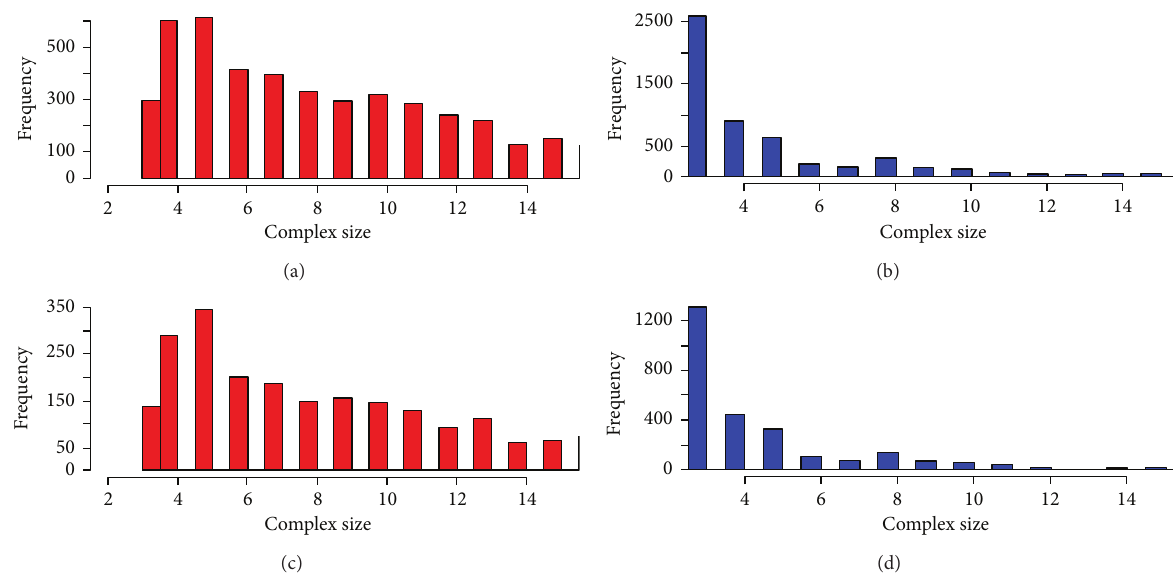
Figure 6: Histogram of complex size in maximal complexes and subcomplexes. (a) Size distribution of the maximal complexes in the full set of nested complexes. (b) Size distribution of subcomplexes in the full set of nested complexes. (c) Size distribution of the maximal complexes in the reliable set of nested complexes. (d) Size distribution of subcomplexes in the reliable set of nested complexes.